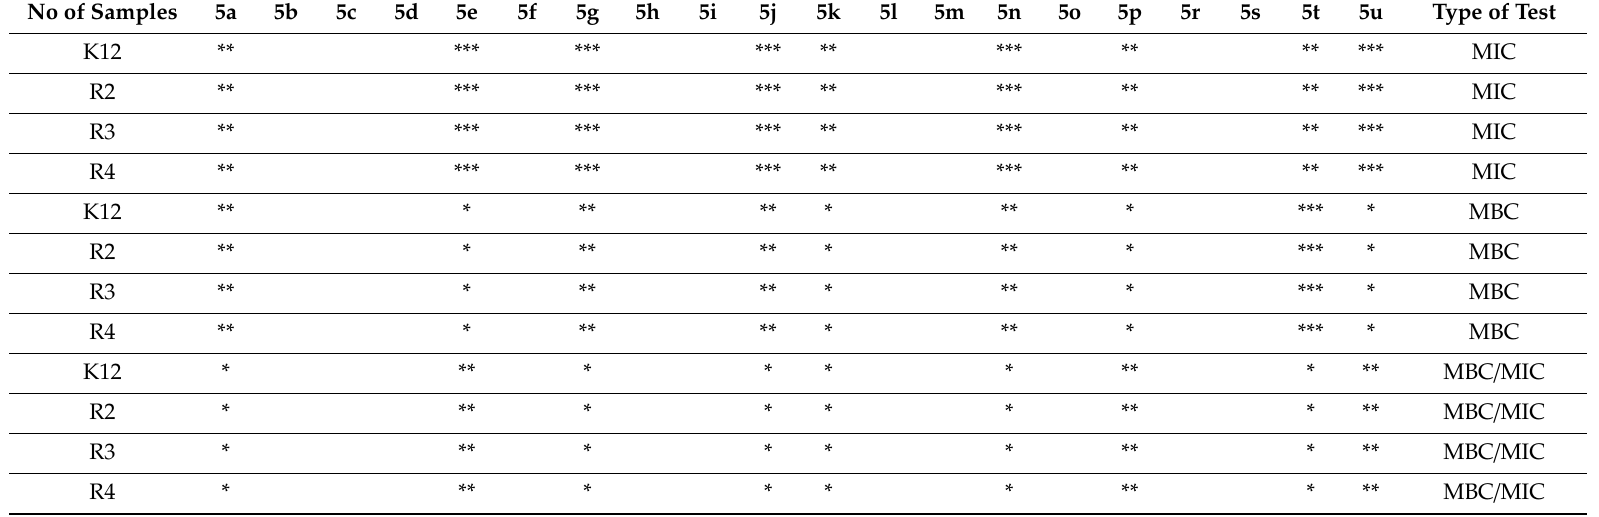
Table 1. Statistical analysis of 20 analyzed compounds by MIC, MBC, and MBC / MIC; < 0.05 *, < 0.01 **, < 0.001 ***. MBC / MIC of the α -amidoamids ratio for the analyzed strains of E. coli K12 and R2–R4. α -amidoamids 5a – 5u were used sequentially. No of